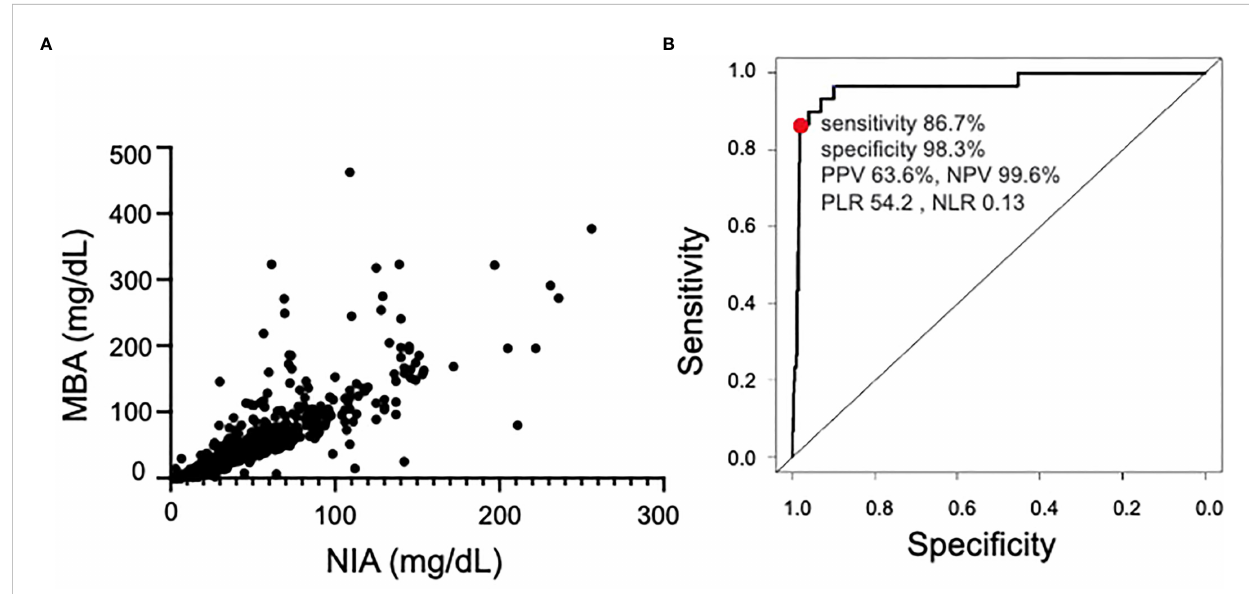
FIGURE 1 Comparison of NIA and MBA. (A) Correlation between NIA and MBA measurements. (B) Receiver operating characteristic curve of the MBA in samples with >135 mg/dL IgG4 as measured with the NIA. Area Under the Curve was 0.97. NIA, nephelometry immunoassay; MBA, magnetic bead panel assay; PPV, positive predictive value; NPV, negative predictive value; PLR, positive likelihood ratio; NLR, negative likelihood